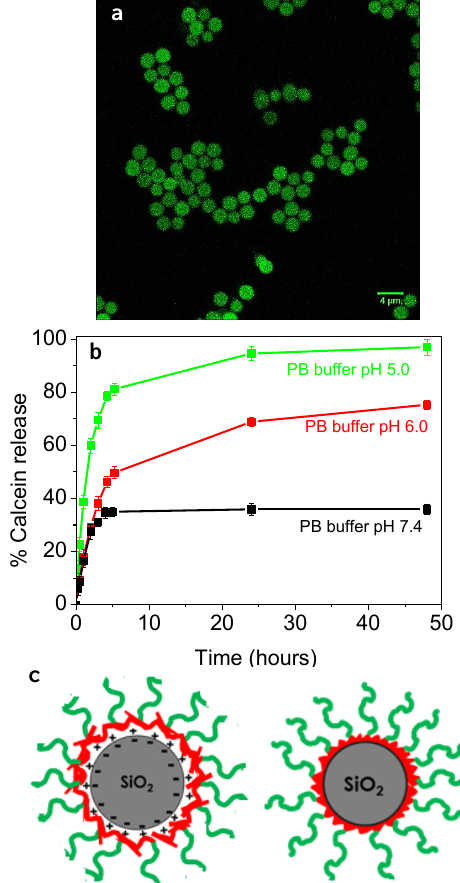
Figure 3. ( a ) Confocal microscopy image of calcein-loaded SiO 2 @P2VP- b -PEO@calcein particles; ( b ) pH-triggered release profile of calcein from SiO 2 @P2VP- b -PEO@calcein particles; ( c ) schematic representation of an SiO 2 @P2VP- b -PEO microparticle in acidic (left) and basic (right) pH environments. The red color represents P2VP and the green color represents PEO. Scale bar in ( a ): 4 μm.